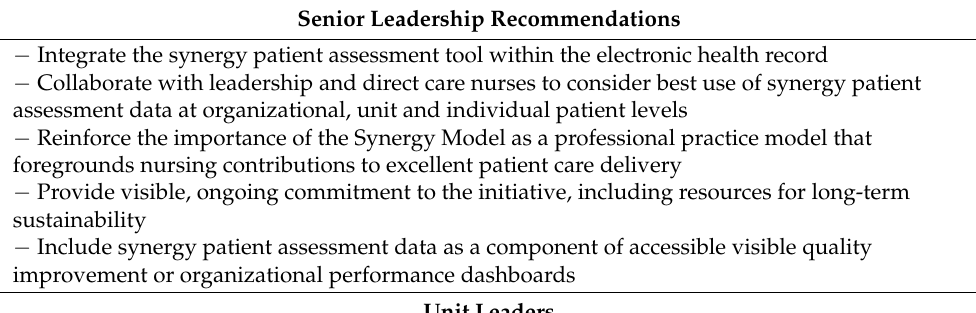
Table 2. Synergy Model implementation